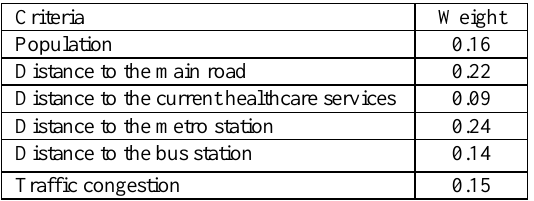
Table 2. Weights of the criteria (scenario#1)